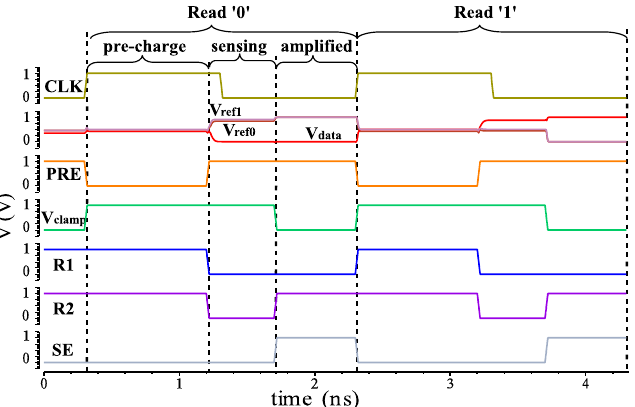
Figure 2. Simulated waveform of proposed HMSS sensing